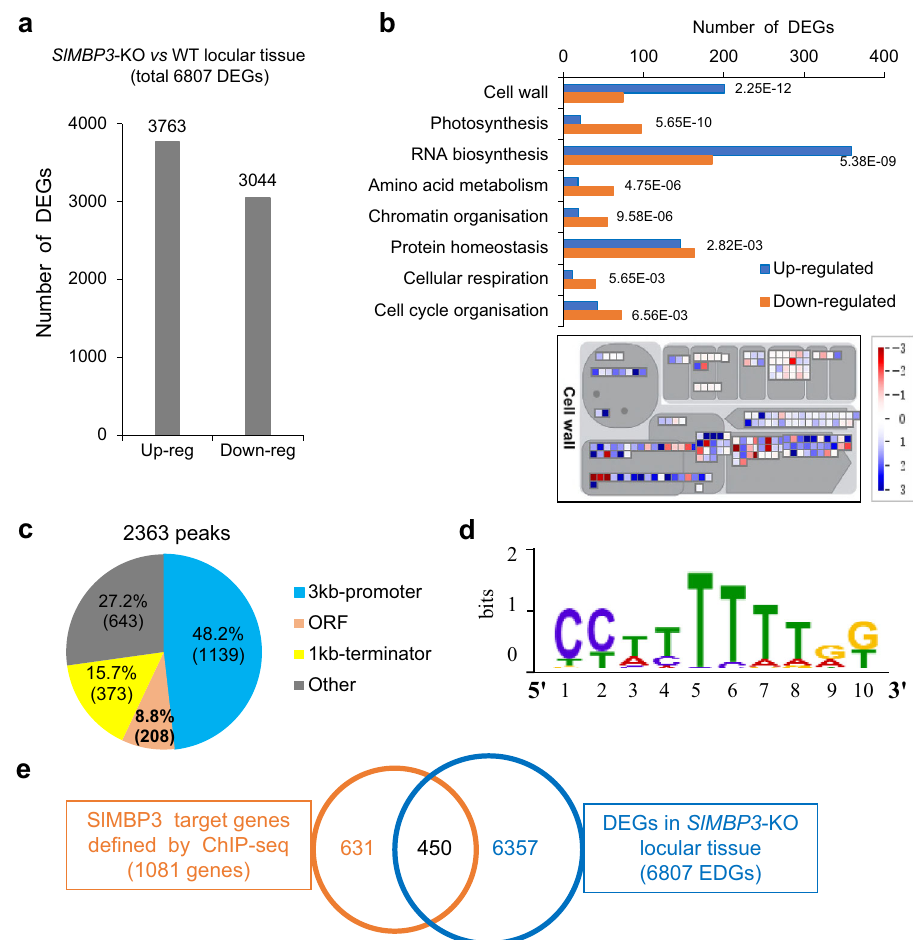
Fig. 5 SlMBP3 target genes identi fi ed by combined genome-wide RNA-seq and ChIP-seq approaches. a Differentially expressed genes (DEGs) in SlMBP3 -KO locular tissue at 10-DPA stage. DPA refers to days post-anthesis. b Top eight enriched functional categories in SlMBP3 -KO locular tissue determined by MAPMAN and showing antagonistic behavior in SlMBP3 up- and downregulated lines. MAPMAN representation (lower panel) of cell wall- related genes differentially expressed between SlMBP3 -KO vs WT locular tissue. Wilcoxon Rank Sum test was used to evaluate the signi fi cance ( p